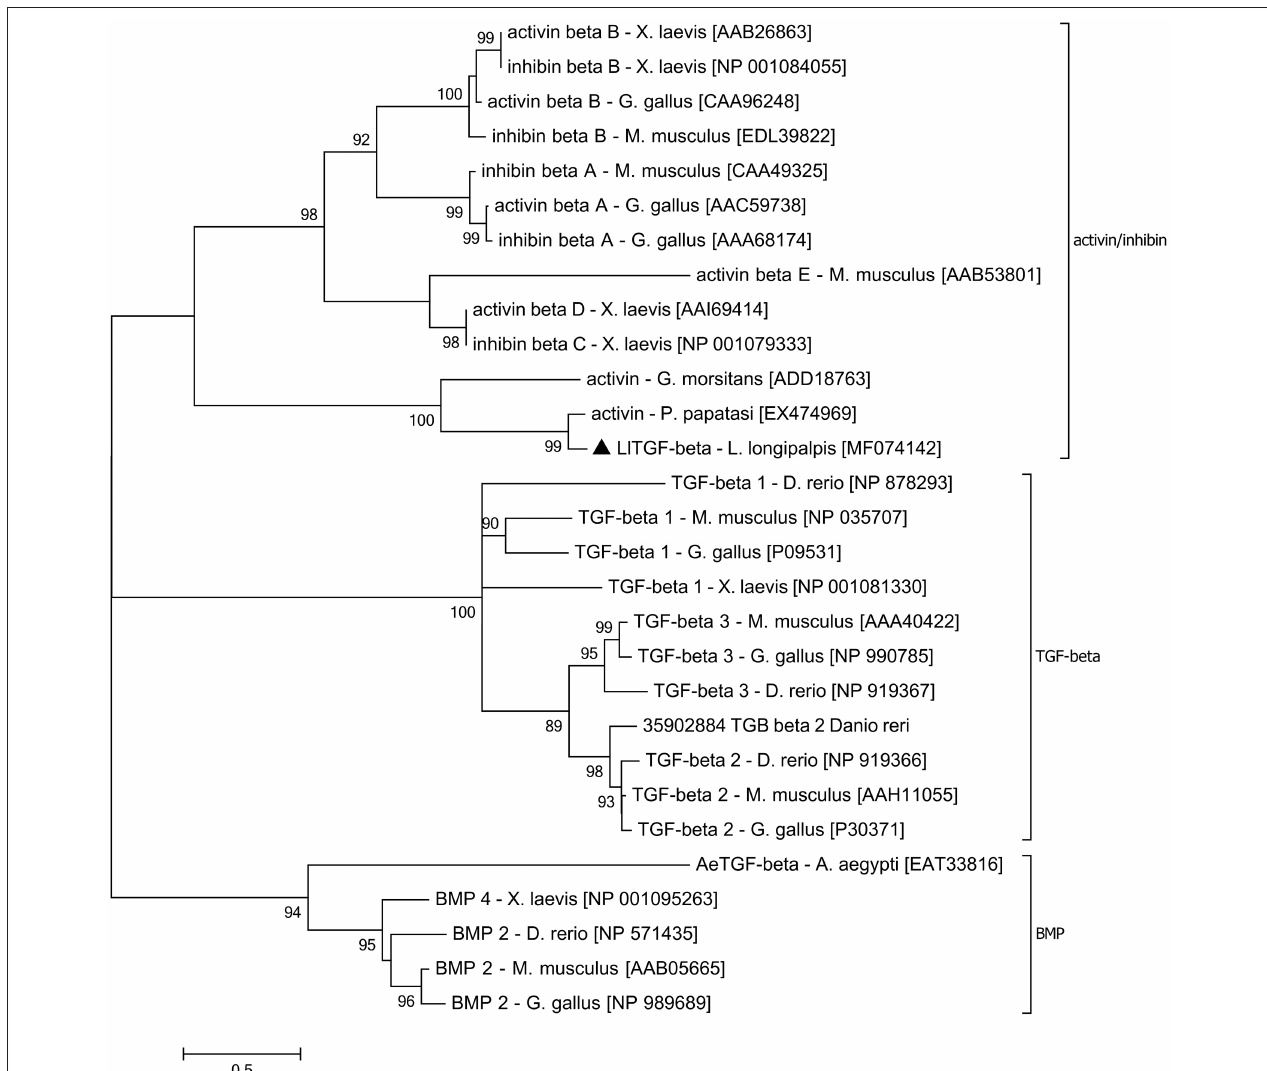
FIGURE 1 | LlTGF- β phylogenetic tree. The LlTGF- β deduced amino acid sequence was aligned with other TGF- β sequences from the insect vectors Aedes aegypti , Glossina morsitans , Phlebotomus papatasi , and the vertebrates Danio rerio , Gallus gallus , Mus musculus , Xenopus laevis . The evolutionary history was inferred using MEGA 6.06 software with Maximum Likelihood method based on the JTT matrix-based model. Evolutionary rate differences among sites [5 categories ( + G, parameter = 3.2942)] were modeled by discrete Gamma distribution. The rate variation model allowed for some sites to be evolutionarily invariable ([ + I], 2.1884% sites). Positions with gaps and missing data were eliminated. The TGF- β subfamily groups are indicated on the right side of the phylogram. Each sequence is labeled with species name followed by GenBank accession number. Branch length represents numbers of substitutions per site. Numbers on the tree nodes indicate bootstrap values higher than 85% (500